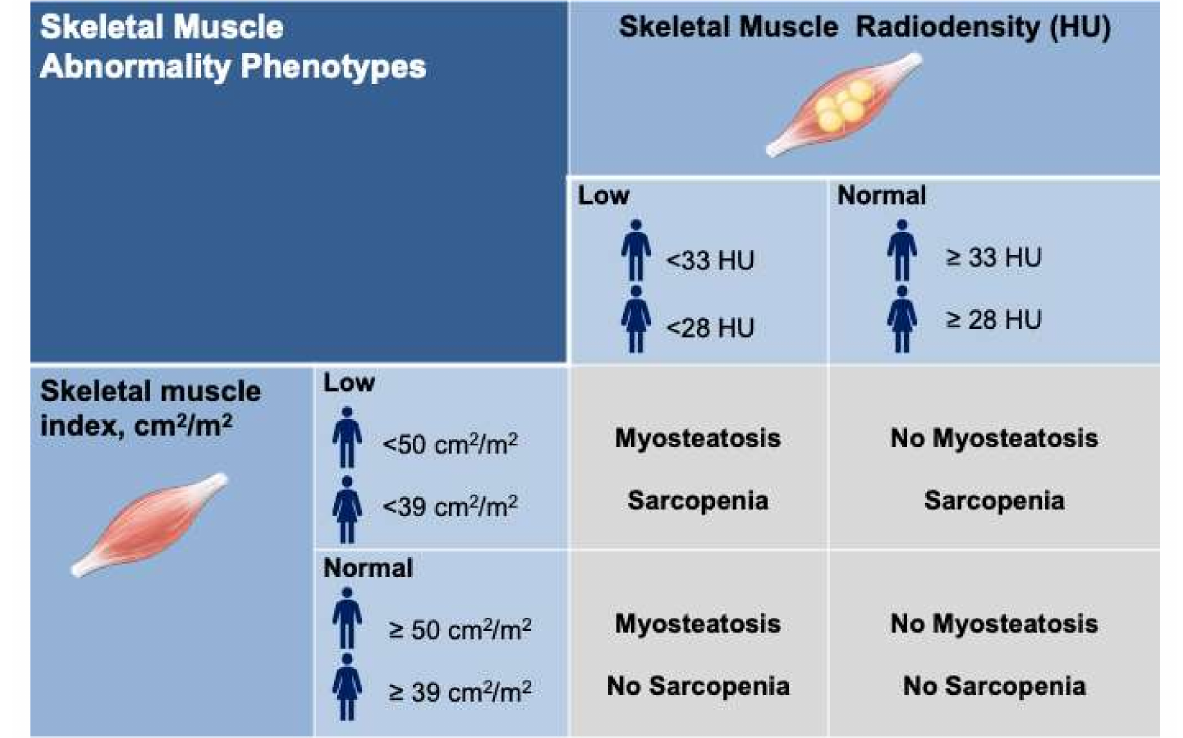
Figure 2. Classification of skeletal muscle abnormality phenotypes. Four-muscle abnormality phe- notypes included those with no skeletal muscle abnormalities (45%), myosteatosis alone (17%), sarcopenia alone (21%) or concurrent sarcopenia and myosteatosis (17%). * Sarcopenia was defined using established cut-offs in patients with cirrhosis as skeletal muscle index < 50 cm 2 /m 2 in males and <39 cm 2 /m 2 in females [17]. Myosteatosis was established as muscle radiodensity <33 HU in males and <28 HU in females.